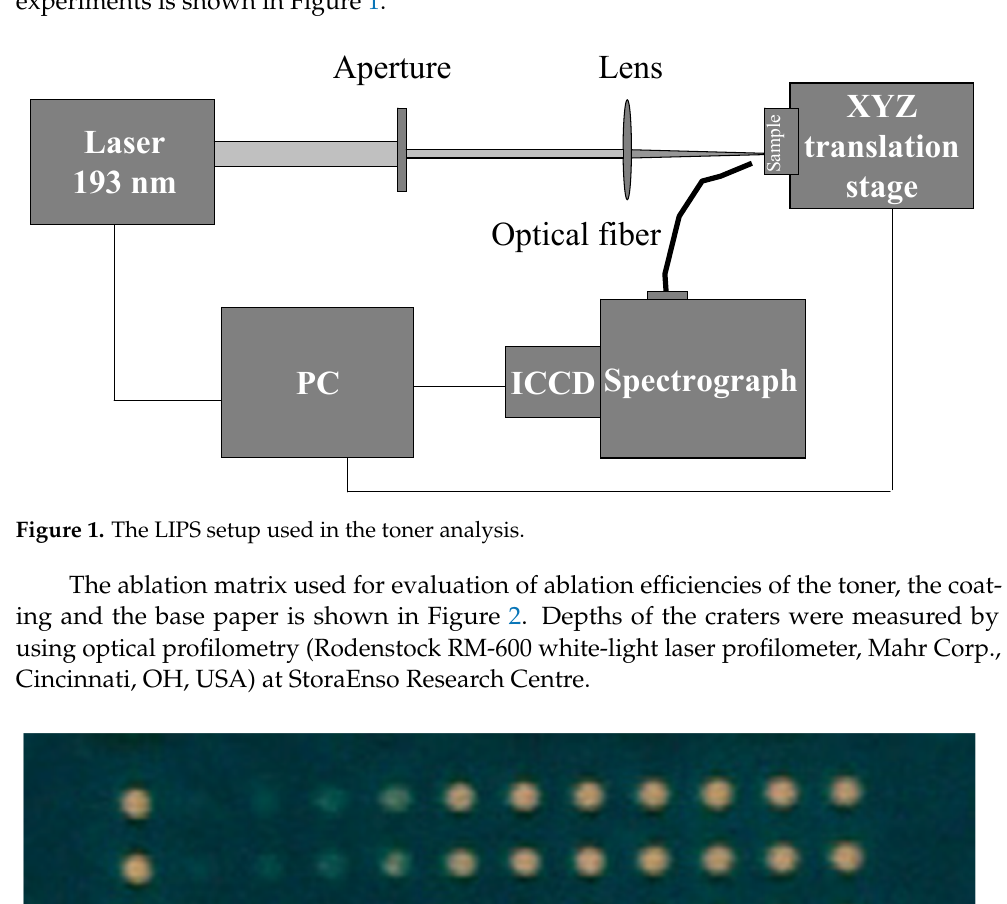
Cincinnati, OH, USA) at StoraEnso Research Centre.